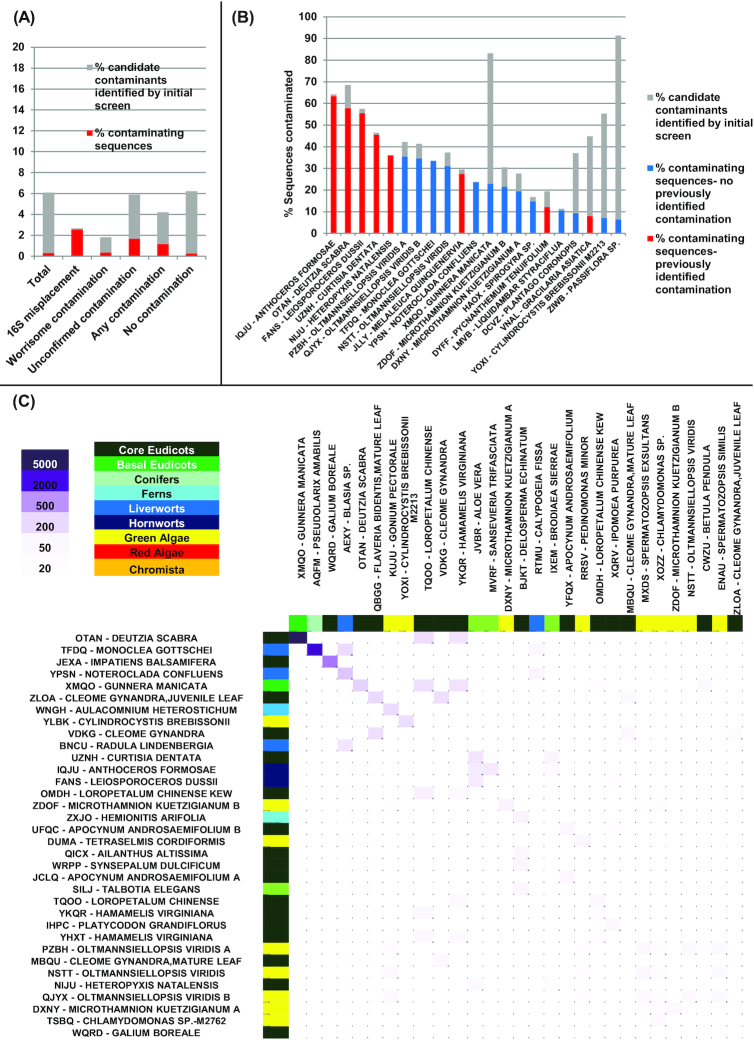
A, Overview of the total sequence percentage verified to be of contaminant origin (red), or inferred to be possible contaminants in other sequence libraries (grey) in all 1KP libraries, and libraries inferred to be contaminated through the 18S phylogenetic placement. B, 21 libraries in which >6% of the total sequences are potential contaminants. C, Heat map of inferred contaminant interactions between pairs of species; contaminated species are shown on the vertical axis and contaminating species on the horizontal axis.